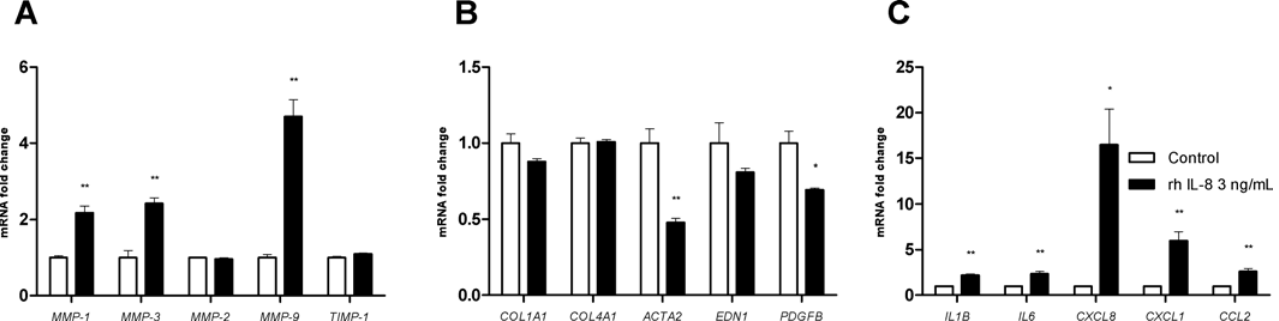
Fig 3. Effects of CXCL8/IL-8 treatment on the fibrolysis balance, fibrotic response and inflammatory response in LX-2 cells. The cells were treated with 3 ng/mL rhIL-8 for 24 hours or 48 hours. (A) mRNA expression of metalloproteinases (MMP-1, MMP-3, MMP-2, MMP-9) and tissue inhibitor of metalloproteinases (TIMP-1), as measured with real-time PCR and normalized against that of GAPDH after 24 hours of treatment. (B) mRNA expression of fibrogenesis factors (COL1A1/collagen I α 1, COL4A1/collagen IV α 1), myofibroblast differentiation factors (ACTA2/ α -smooth muscle actin) and myofibroblast activation factors (EDN1/endothelin-1, PDGFB/platelet-derived growth factor-BB), as measured with real-time PCR and normalized against that of GAPDH after 24 hours of treatment. (C) mRNA expression of proinflammatory cytokines (IL1B/interleukin-1 β , IL6/interleukin-6) and chemokines (CXCL8/interleukin- 8, CXCL1/GRO α , CCL2/MCP1), as measured with real-time PCR and normalized against that of GAPDH after 24 hours of treatment. Results are expressed as the mean ± SEM of three independent experiments. * p < 0.05, ** p < 0.01, relative to a